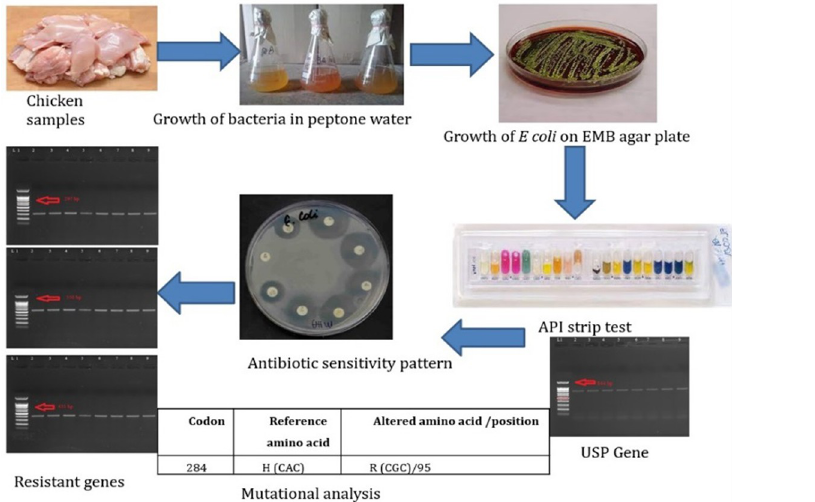
Fig 1. Flowchart of the methods used in the